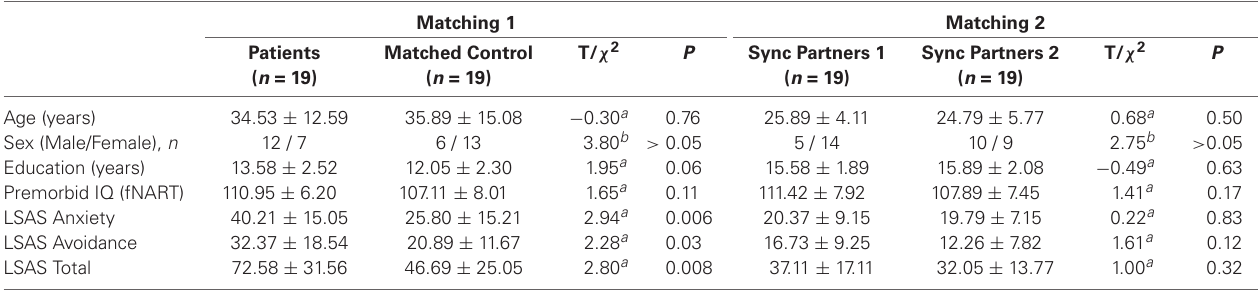
Table 1 | Mean ± standard deviation of demographic characteristics of